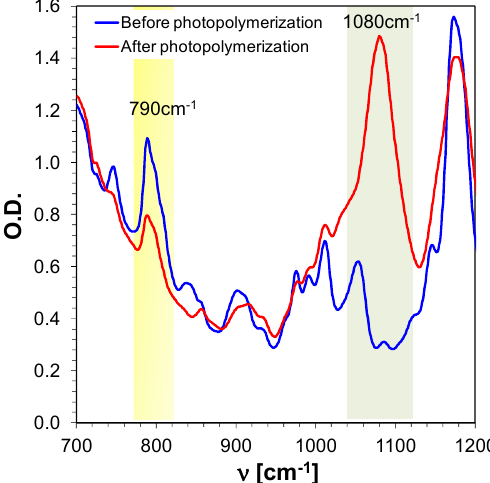
Figure 16. FT-IR spectra before and after polymerization of epoxy monomer UVACURE ® 1500 under LED@405 nm in the presence of sulphonium salt TAS (2% w / w ) and sensitizer T1 (0.2% w / w ).